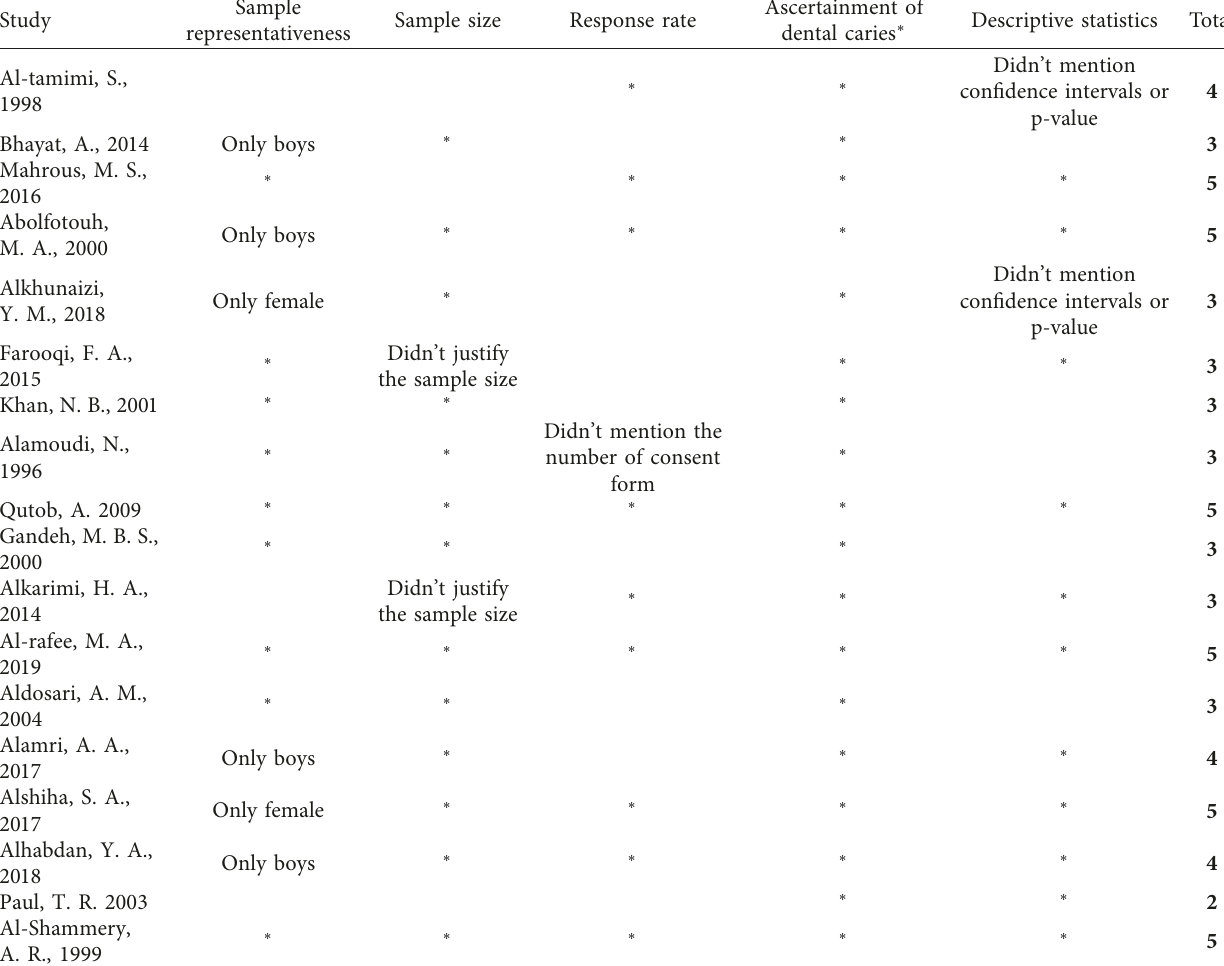
Table 2: Modified newcastle-ottawa risk of bias score for the 20 studies included in this systematic review and meta-analysis. Sample Study Sample size Response rate representativeness